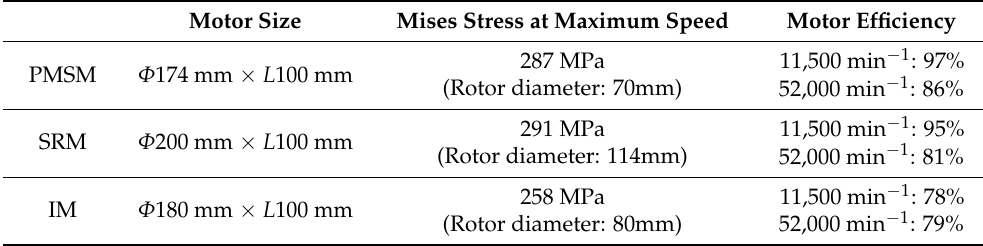
Table 7. Motor performances of high-speed